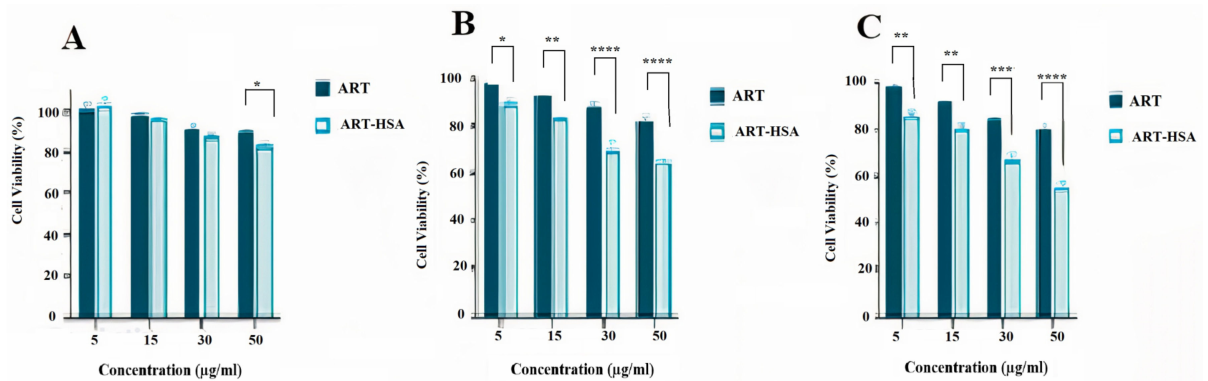
Figure 4. The release rate of nanoparticles exposed to citrate buffer with acidic pH and phosphate buffer with neutral pH at intervals of 0 to 72 h.